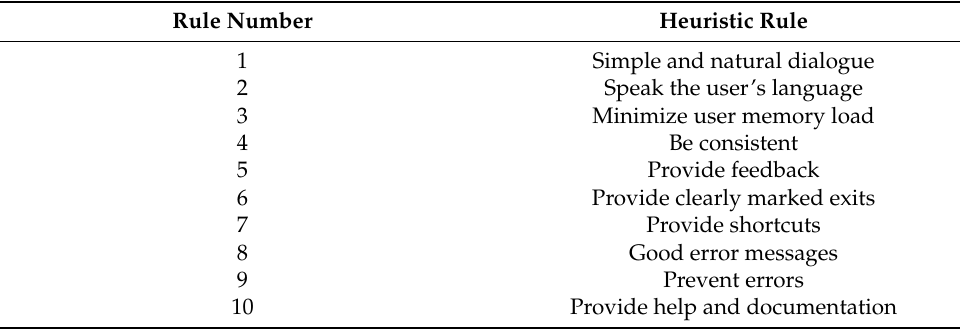
Table 2. Heuristic rules to examine the usability of the serious